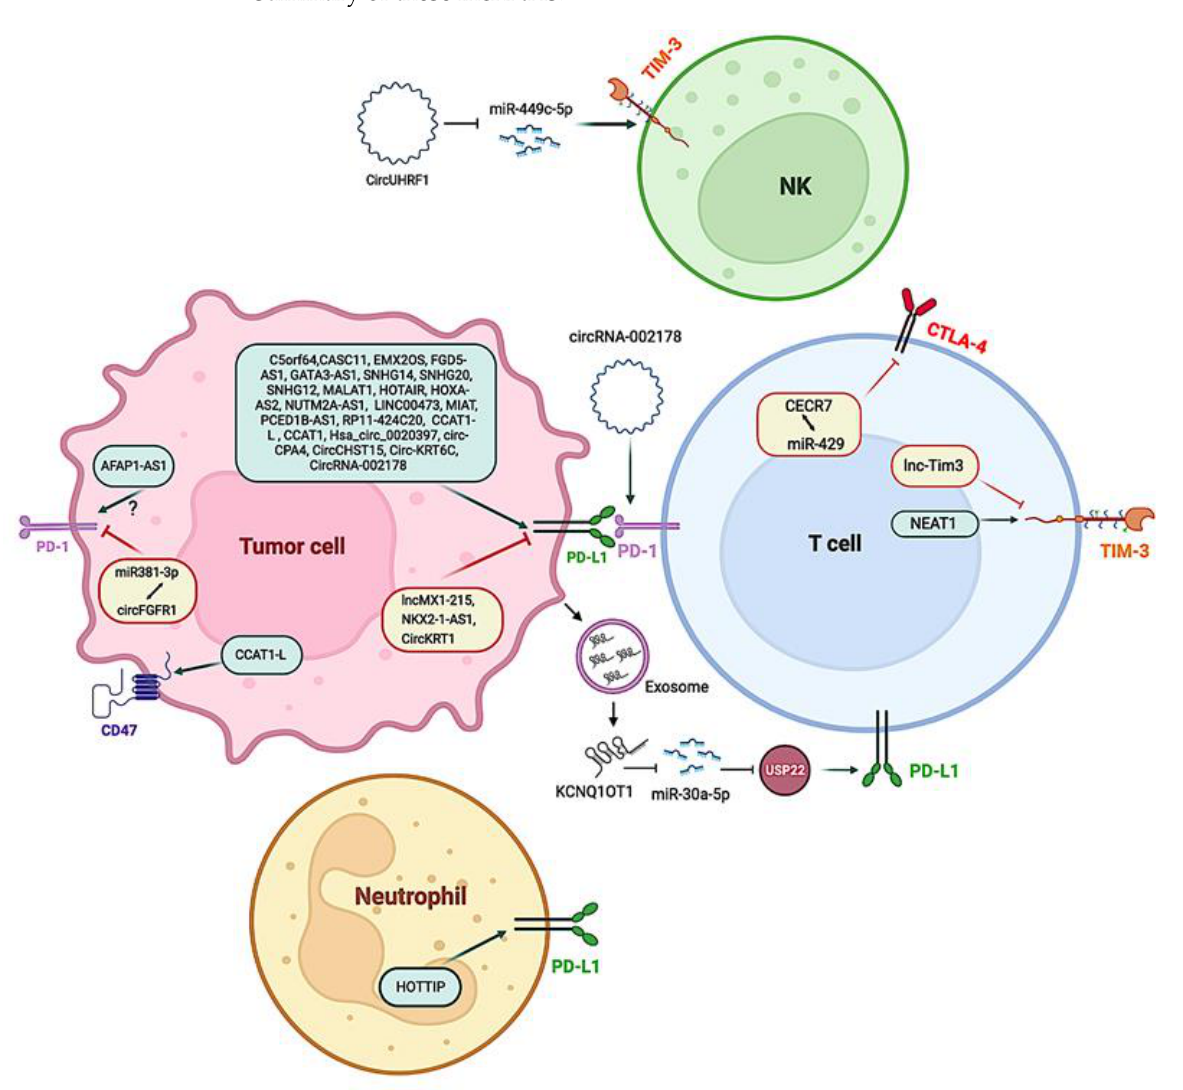
Figure 4. Regulation of immune checkpoint (IC) molecules by lncRNAs in human cancer. Modulatory effects of lncRNAs on T cells, neutrophils, and NK cells. lncRNAs (linear and circular RNAs) regulate different ICs, including PD-1, PD-L1, CD47, and TIM-3 in cancer cells, T cells, neutrophils, and NK cells. Green arrows denote stimulatory regulation. Red T-shaped symbols represent inhibitory regulation. Created with Bio.Render.com.